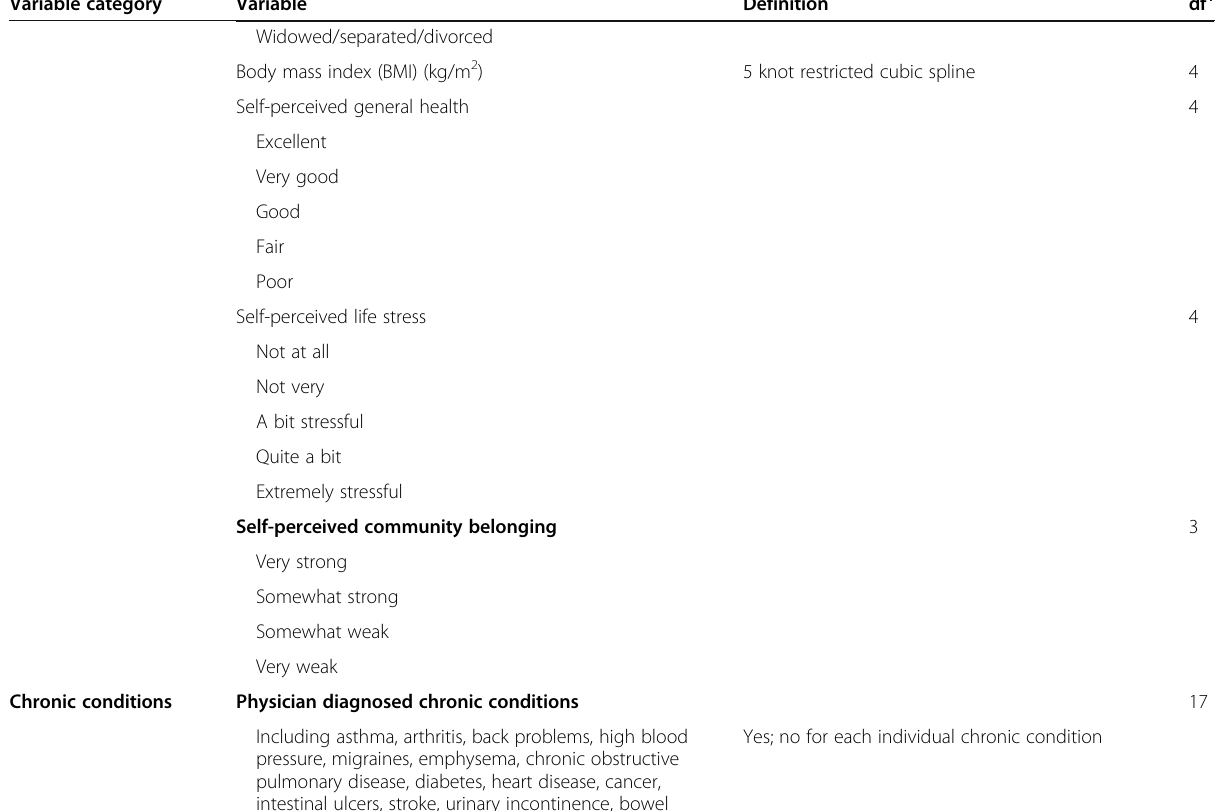
Table 1 Pre-specification of PreMPoRT predictive variables (Continued) Variable